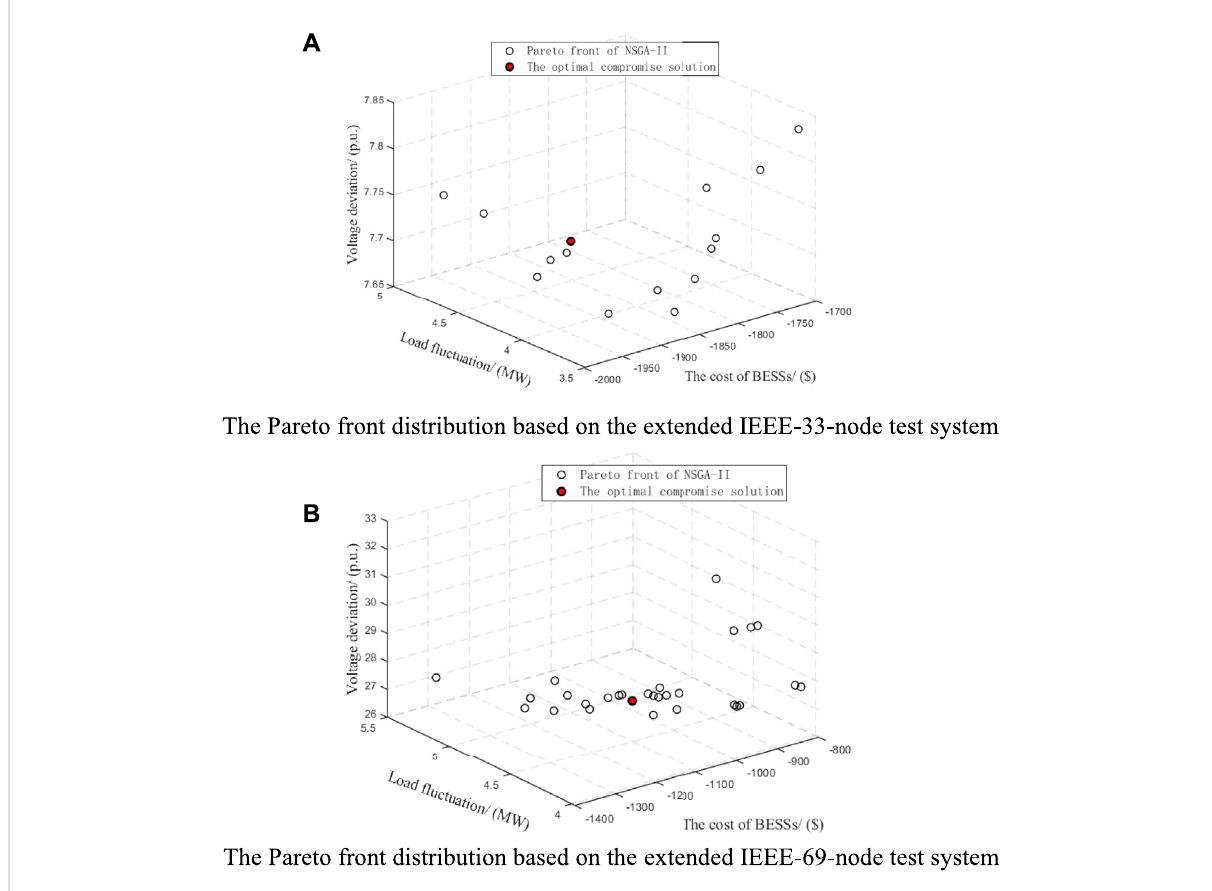
FIGURE 9 The Pareto front distribution obtained by NSGA-II. (A) The Pareto front distribution based on the extended IEEE-33-node test system. (B) The Pareto front distribution based on the extended IEEE-69-node test